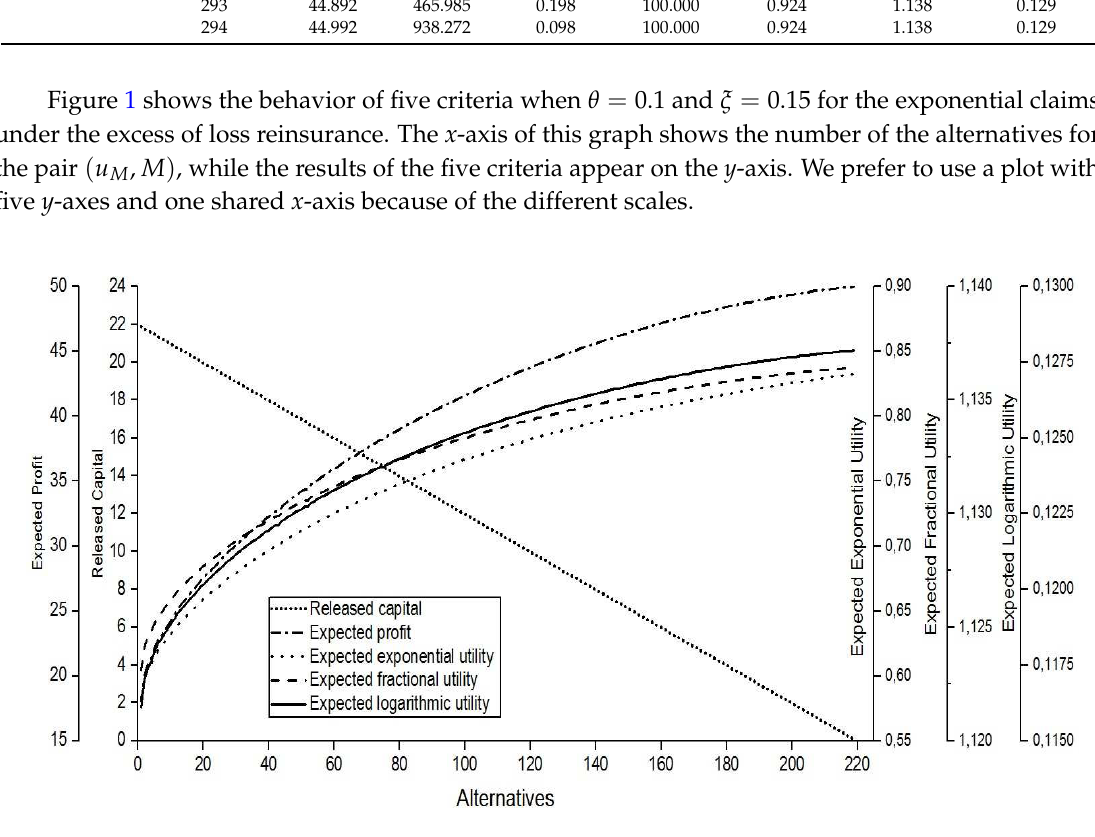
Figure 1. The graph of the criteria when θ = 0.1 and ξ = 0.15 for the exponential